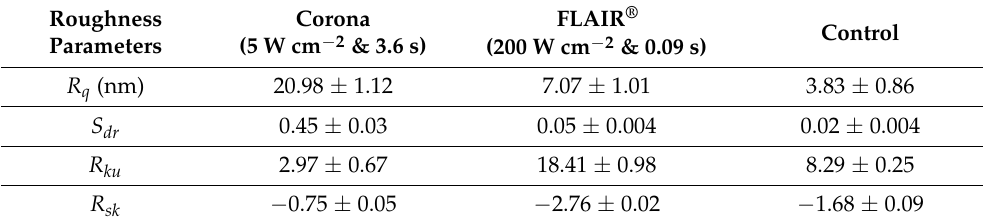
Figure 3. X-ray ptychography ( A ) and SEM ( B ) images of plasma-treated and control PET films. ∆ z is the peak-to-valley difference. Table 1. Roughness parameters root-mean-square ( RMS ) roughness R q , interfacial development S dr , kurtosis R ku and skewness R sk of plasma-treated and untreated control PET